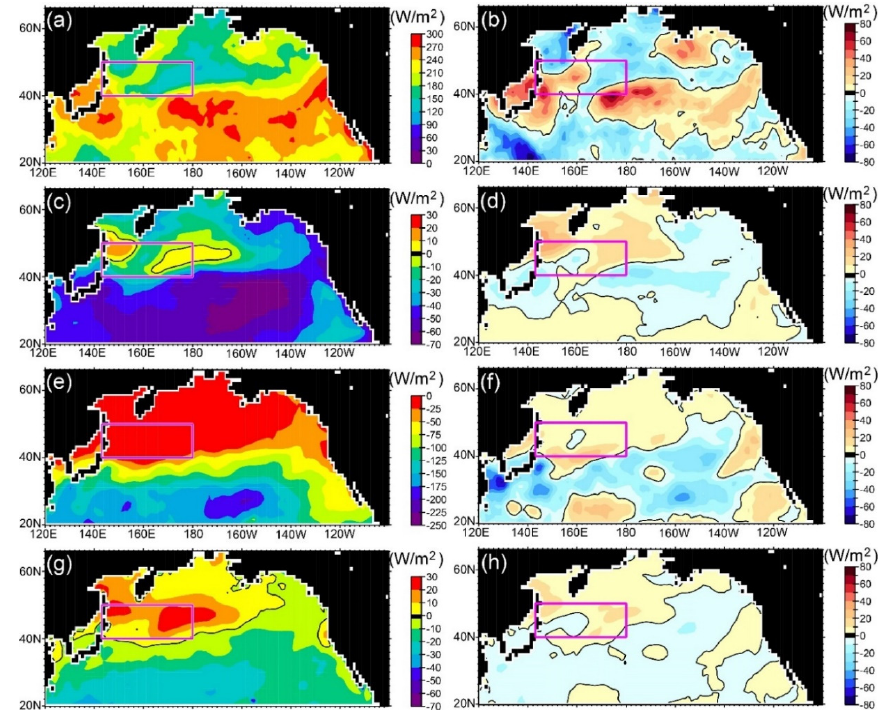
Figure 4. ( a ) Net shortwave radiation, ( c ) net longwave radiation, ( e ) latent heat, and ( g ) sensible heat flux averaged over 10–30 July 2021. Anomalies of ( b ) net shortwave radiation, ( d ) net longwave radiation, ( f ) latent heat, and ( h ) sensible heat flux.